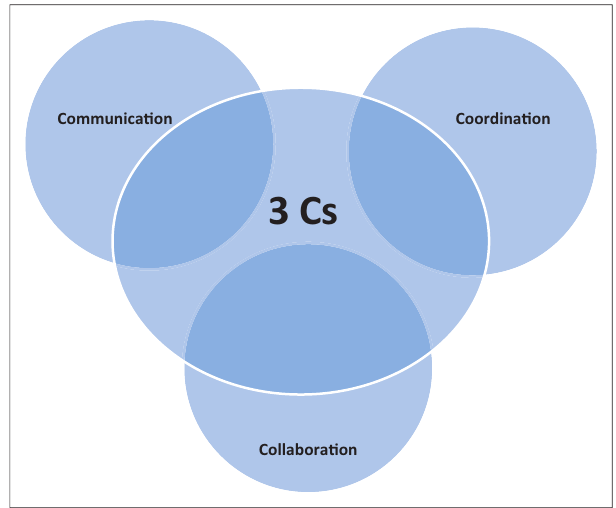
FIGURE 2: Knowledge management’s three Cs for managing